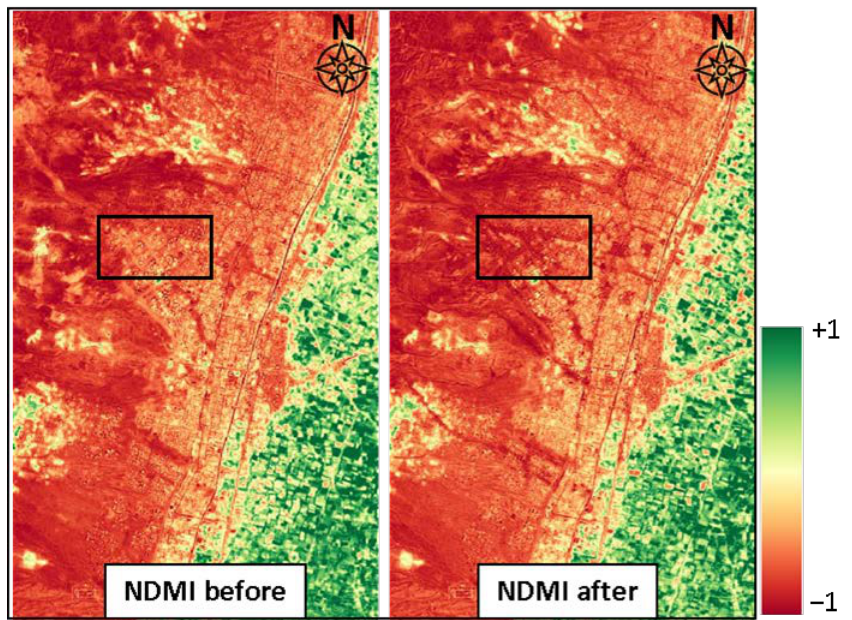
Figure 8. Observation of changes in the study area using pre- and post-event NDMIs.